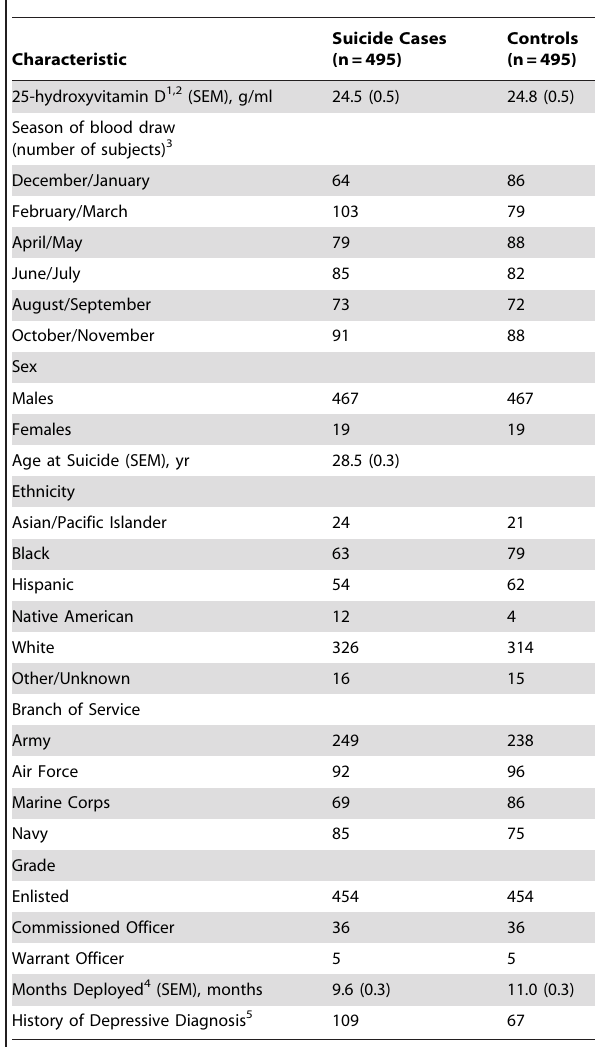
Table 1. Mean plasma 25(OH)D levels and baseline characteristics for cases and